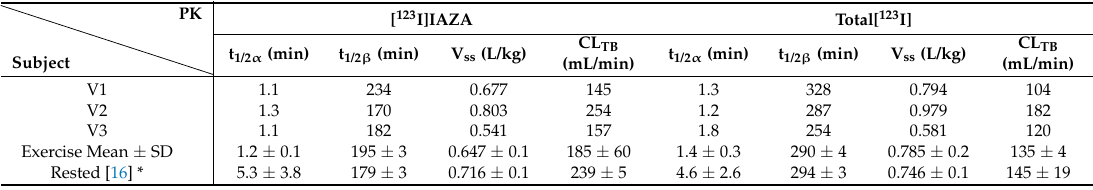
Table 2. Pharmacokinetic (PK) parameters for [ 123 I]IAZA and total[ 123 I] in exercise-stressed volunteers. Published data for rested volunteers [16] are included for comparison.